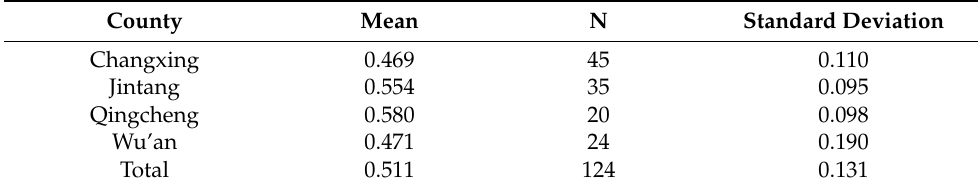
Table 7. Comparison of standard deviations in different county-level towns.